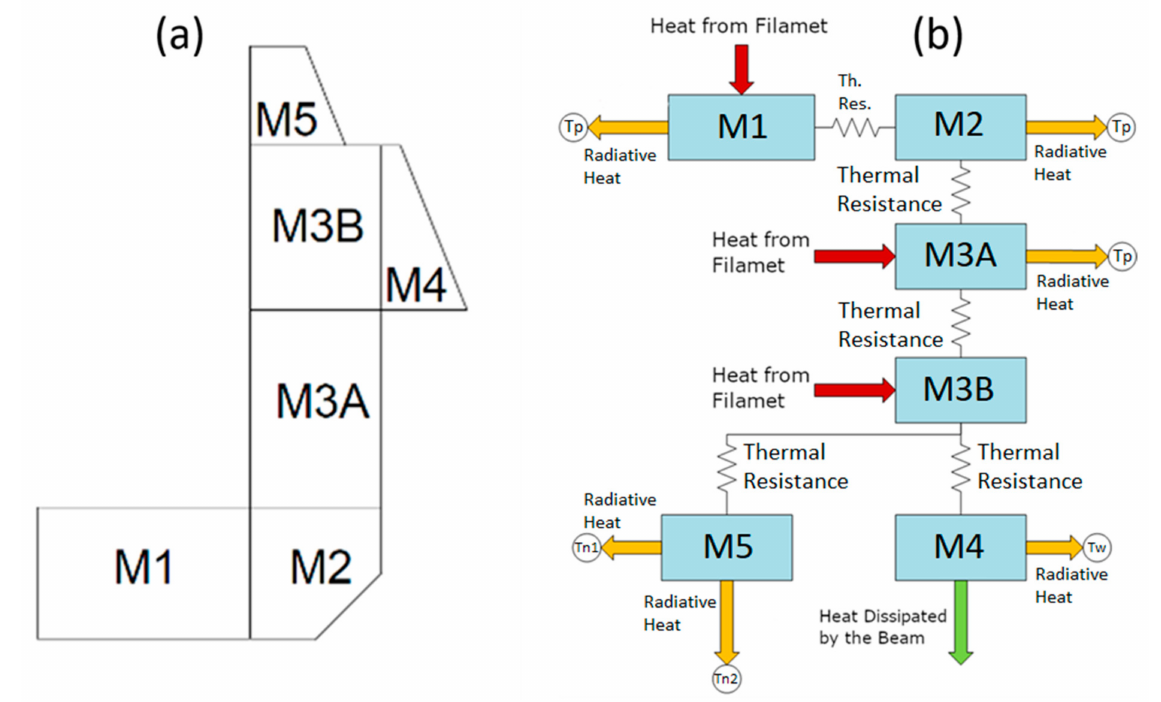
Figure 13. Scheme of the emitter ring sectioning ( a ) and of the models used to calculate heat transfer in the system ( b ). The radiative heat terms, thermal resistances, and beam heat are calculated according to Equations (5)–(7). Tn1 and Tn2 represent the average temperature of the nosecone seen by mass M5; Tw and Tp represent the average temperature of the MIG wall and of the